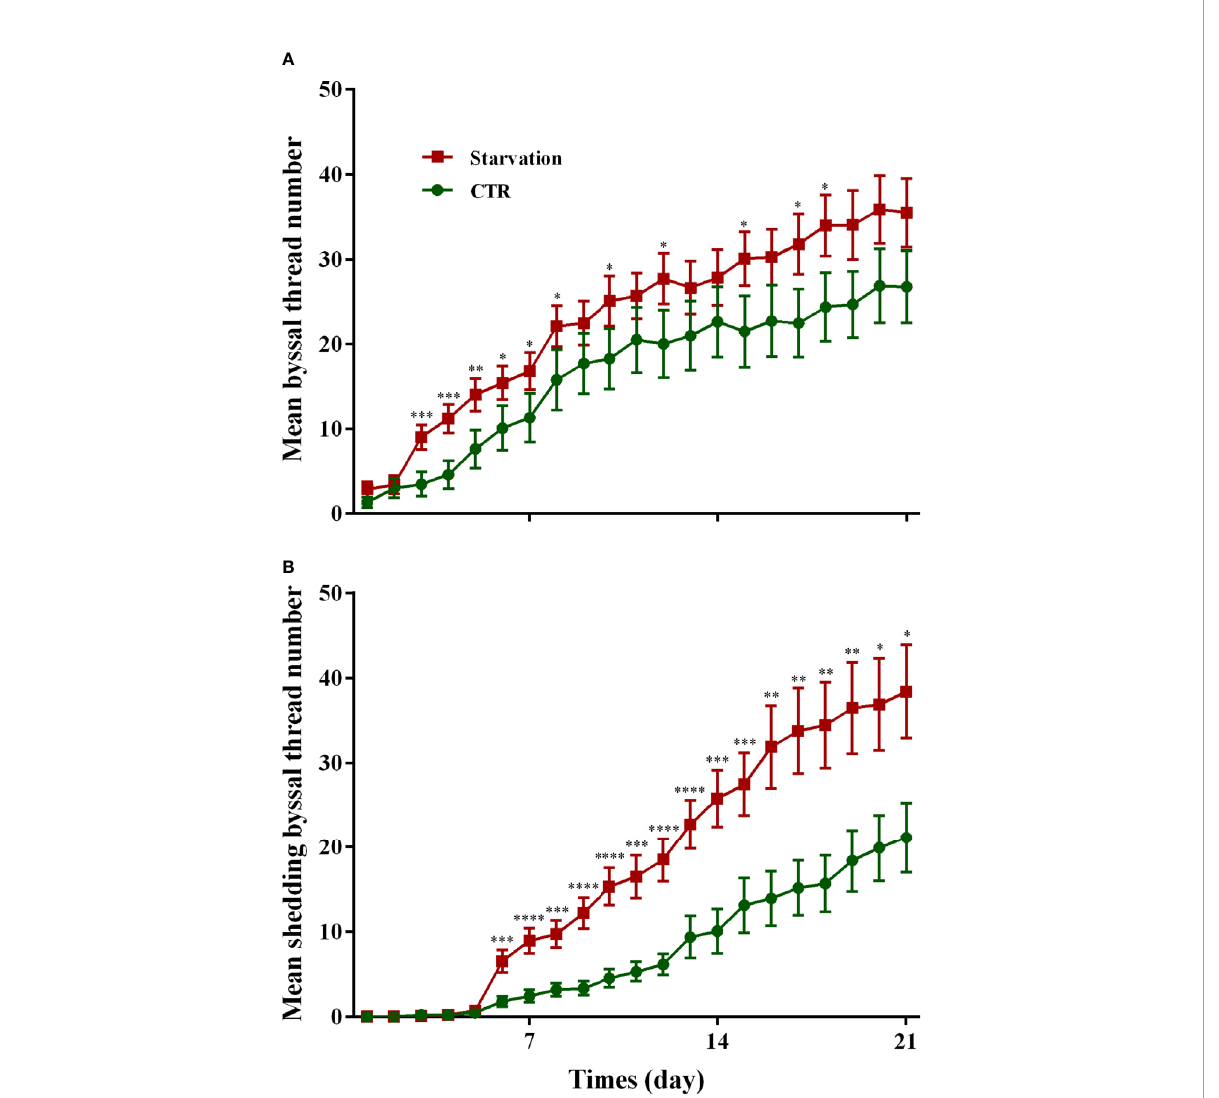
FIGURE 1 Effects of 21 days of starvation on the (A) secreted byssal thread number and (B) byssal shedding number in M. coruscus . CTR: control group. Asterisks indicate signi fi cant differences between starvation groups and CTR groups. * p < 0.05; ** p < 0.01; *** p < 0.001; **** p <